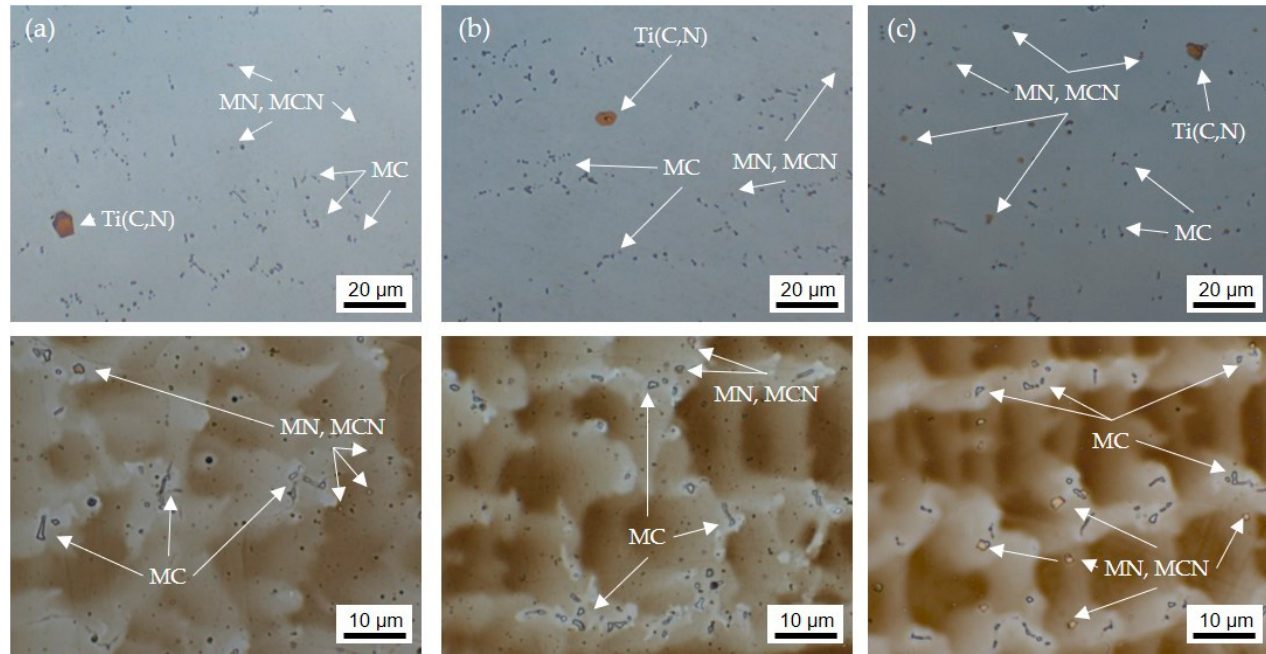
Figure 13. Micro sections (Y–Z plane) of walls with HY282 ( Φ 0.035 ″ ). ( a ) ArHeHC; ( b ) ArHeH; ( c ) ArHeNC ( top : polished, bottom : etched with Beraha III).